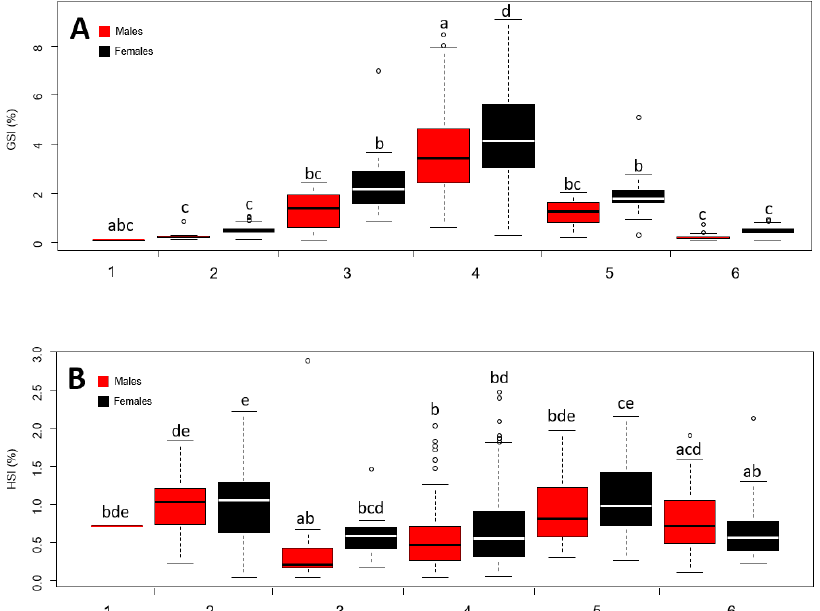
Figure 3. Gonadosomatic and hepatosomatic indices by sex and reproductive developmental stage in the European sardine ( S. pilchardus ). ( A ) Gonadosomatic index (GSI) by sex and reproductive developmental stage. ( B ) Hepatosomatic index (HSI) by sex and reproductive developmental stage according to the classification of Brown-Peterson et al. [48]. Different letters on the graph indicate significant differences among stages and/or between sexes. Outliers are marked with a circle (°).